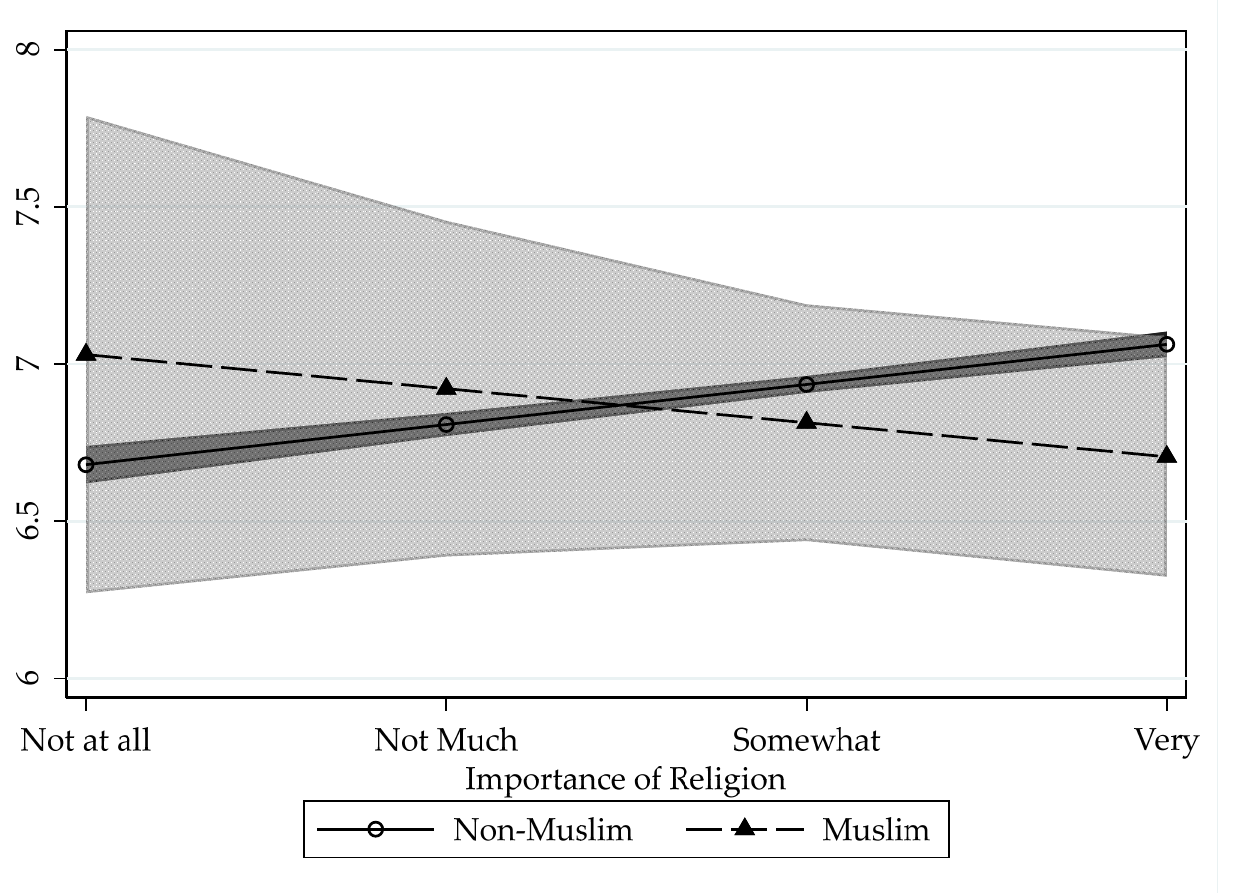
Figure 3. Importance of Religion and Attitudes toward Jews for Muslims and Non-Muslims. Source: Nationscape, based on results from Table 1, Model 4. The line with the circle represents the predicted regression effects for non-Muslims and the line with the black triangle is for Muslims. The right vertical axis is the predicted Antisemitism Index score.